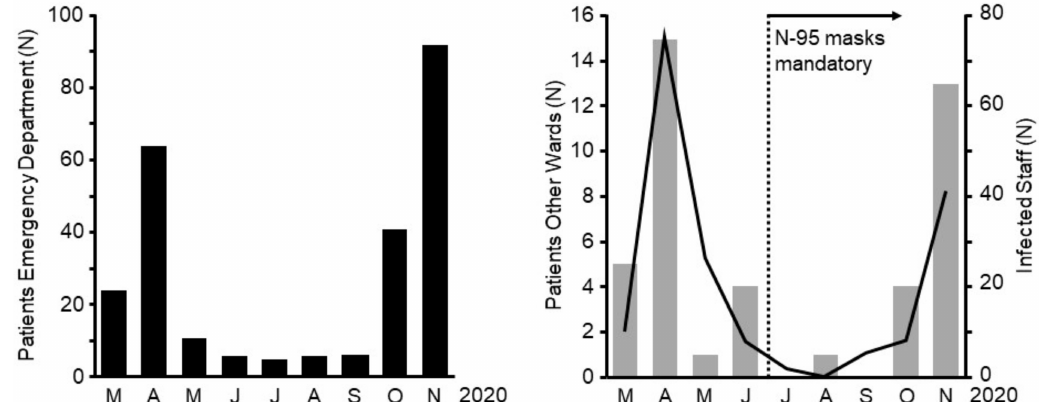
Figure 6. Number of SARS-CoV-2 infected patients treated in Ingolstadt hospital and number of SARS-CoV-2 infected Scheme 2. infection diagnosed at the emergency department (ED). Right: patients who were tested positive after admission to the hospital when being treated on other wards (grey bars, left y -axis) and number of staff members with confirmed SARS-CoV-2 infection (black line, right x -axis). Starting in late June, wearing N-95 (FFP-2) masks was introduced as mandatory during direct patient interactions for all staff members of Ingolstadt